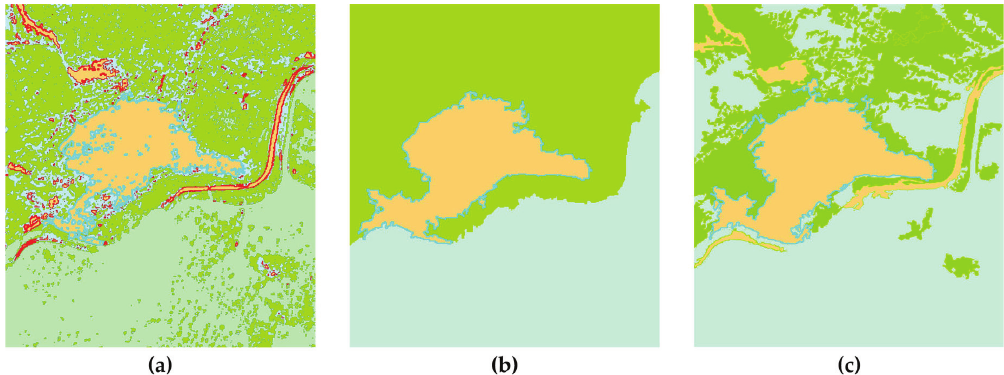
Figure 6. Comparison of extraction of unstable slopes using the three methods: ( a ) MLC, ( b ) OOC, and ( c ) Luv-RMWS.